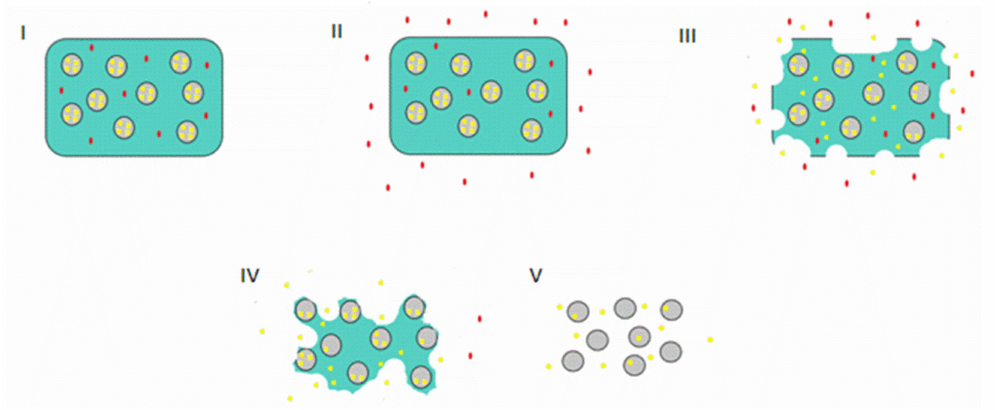
Figure 7. Scheme of a sequential delivery ( I ) microparticles in hydrogel loaded with two drugs (red in the hydrogel and yellow within the microparticles), ( II ) the red drug begins to be released at an early stage, ( III ) the hydrogel starts to degrade and the yellow drug diffuses trough the hydrogel, ( IV ) the red drug is completely released with the hydrogels degradation, ( V ) the micropar- ticles stop being protected by the hydrogel and the yellow drug will be fully released with the complete degradation of the particles.